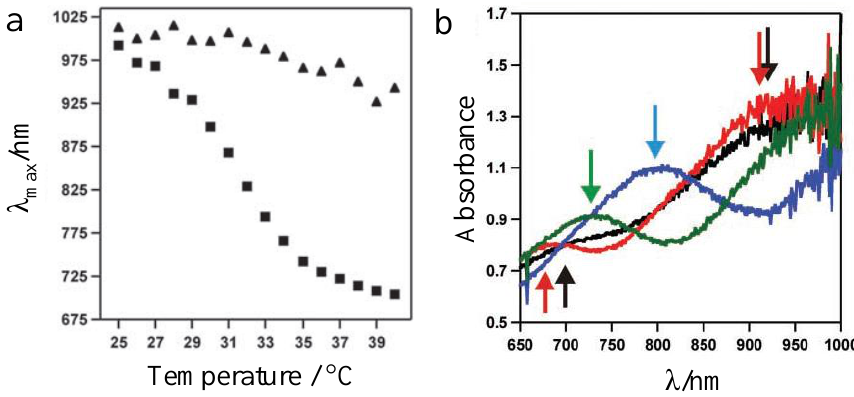
Figure 2. ( a ) λ max as a function of temperature for pNIPAm-co-AAc microgel-based etalons at (squares,  ) pH 3.0, and at (triangles, ) pH 6.5. ( b ) Absorbance (actually reflectance) as a function of at different temperatures; (black) 25 °C, (red) 29 °C, (blue) 33 °C, and (green) 37 °C. Reproduced with permission from